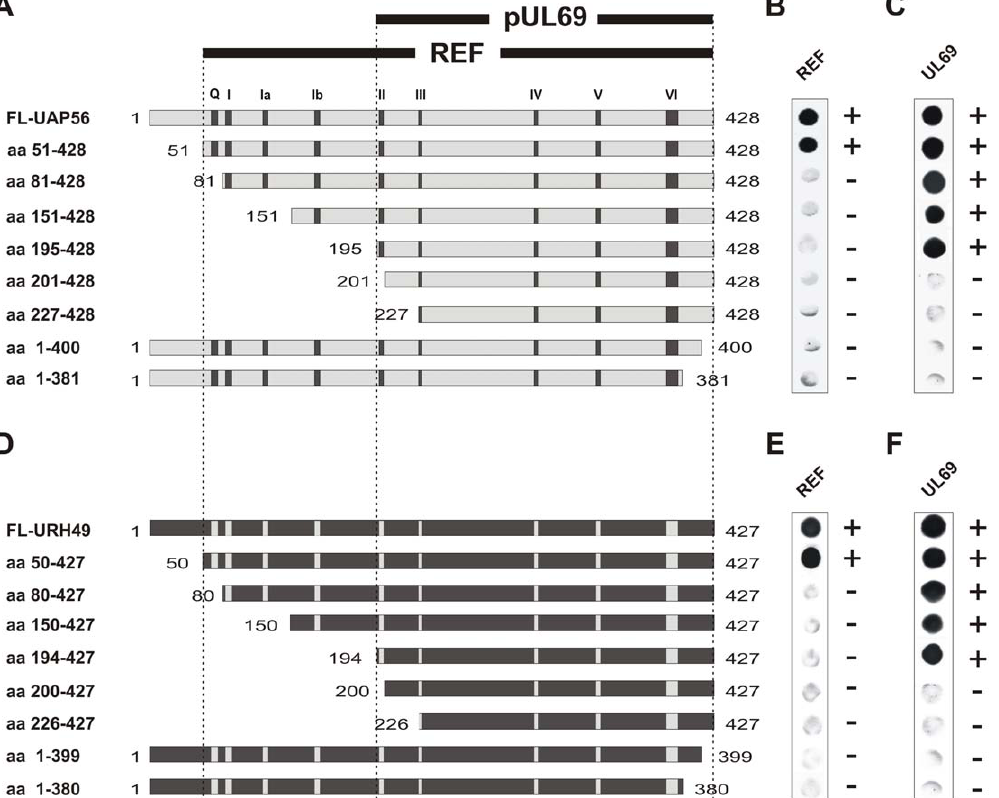
Figure 5. Mapping of the REF- and pUL69-interaction domain within UAP56 and URH49. (A–F) Yeast two-hybrid analysis: Yeast cells were transformed with full-length, or N- and C-terminal deletion mutants of UAP56 (A) or URH49 (D) as in-frame fusions to the GAL4 activation domain in combination with a vector encoding REF (B + E) or UL69 (C + F) in fusion with the GAL4 DNA-binding domain as indicated. Growth-selected yeast cells were analyzed in filter-lift assays for the expression of b -Gal, indicated by blue-staining of the respective colony. The mapped interaction regions that were required and sufficient for pUL69- (aa195/194-428/427) or REF-interaction (aa51/50-428/427) of UAP56 or URH49, respectively, are highlighted by black